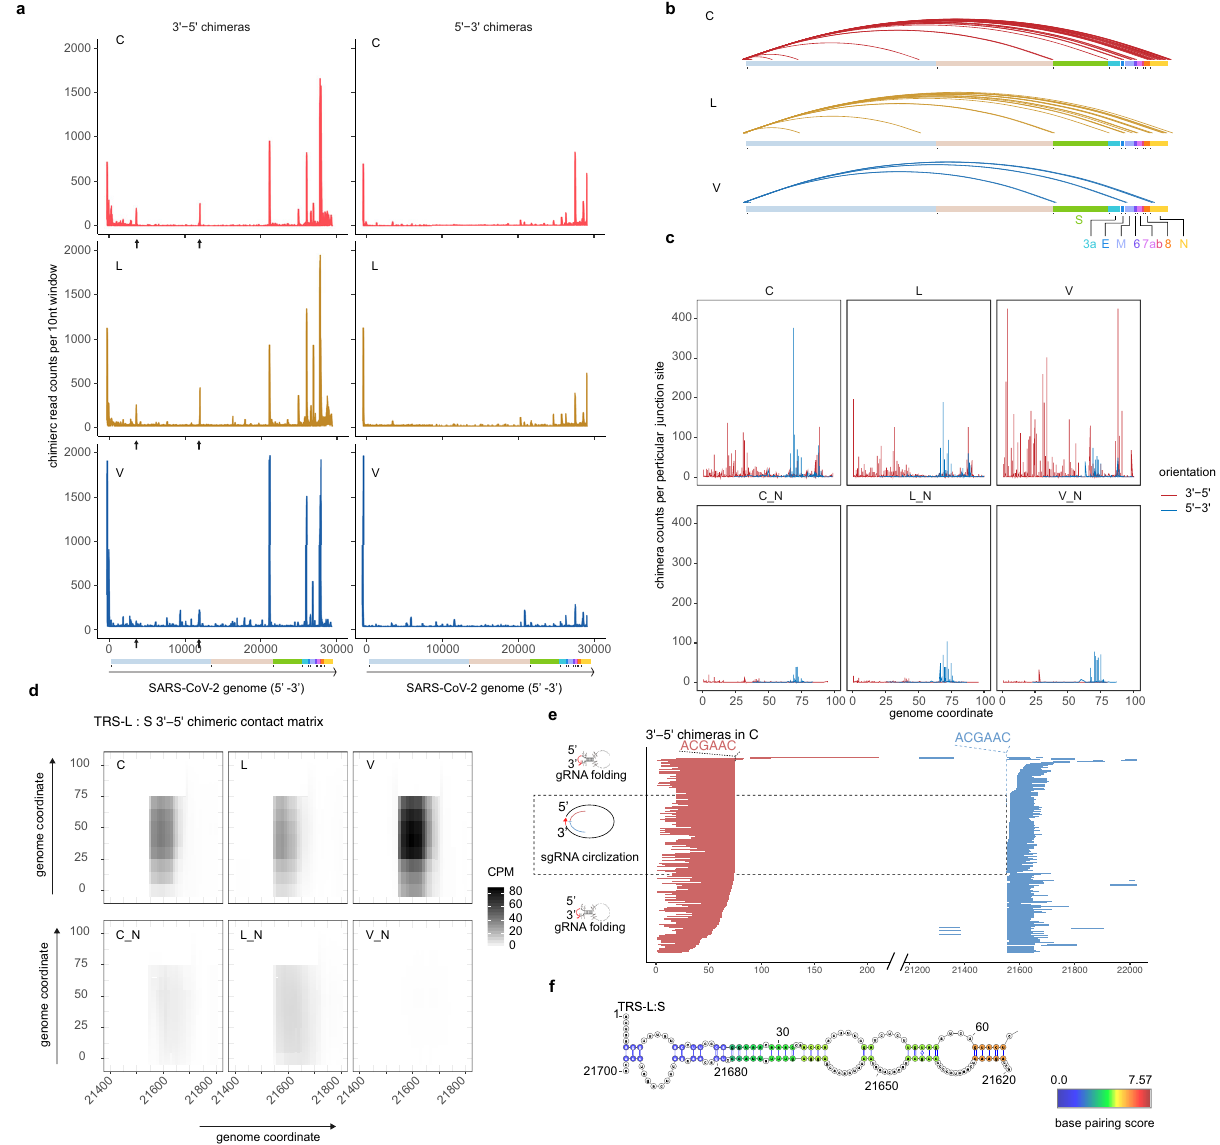
Fig. 2 TRS-L interact with canonical TRS-B sites. a Viewpoint histograms showing binding positions of the TRS-L region ( fi rst 100 nt) along the SARS- CoV-2 genome in indicated samples. The 3 ′ – 5 ′ chimeras and 5 ′ – 3 ′ chimeras were separately plotted. Black arrowheads indicate additional peaks in orf1a. b Enriched TRS-L interaction peaks deduced from Z -score method. Chimeric read counts from bin – bin contacts were normalized by Z -score, then interactions with Z -score > 2.13 (95% con fi dence of being above average) and mediated by TRS-L were plotted. c Junction site distribution on TRS-L region (the fi rst 100 nt), chimeras that break at exactly particular base were counted, showing that the ligation happened in varied sites. Lines show frequencies of junction points of chimeras (3 ′ – 5 ′ chimeras in red and 5 ′ – 3 ′ chimeras in blue), which localized before nt100. d Contact matrix of 3 ′ – 5 ′ chimeric reads spanning TRS-L: S junction sites. Color depicts counts of chimeric reads per one million mapped reads (CPM). e Randomly selected 3 ′ – 5 ′ chimeras overlapping the TRS-L: S junction sites. The red lines indicate 3 ′ -arms of chimeric reads, whereas blue lines indicate 5 ′ -arms of chimeric reads. Chimeric reads with varied ends are derived from random fragmentation and ligation, re fl ecting long-range RNA – RNA interactions. f RNA base pairing between TRS- L and upstream of S, paired bases were colored by log2 chimeric read counts supporting each base pair (in C